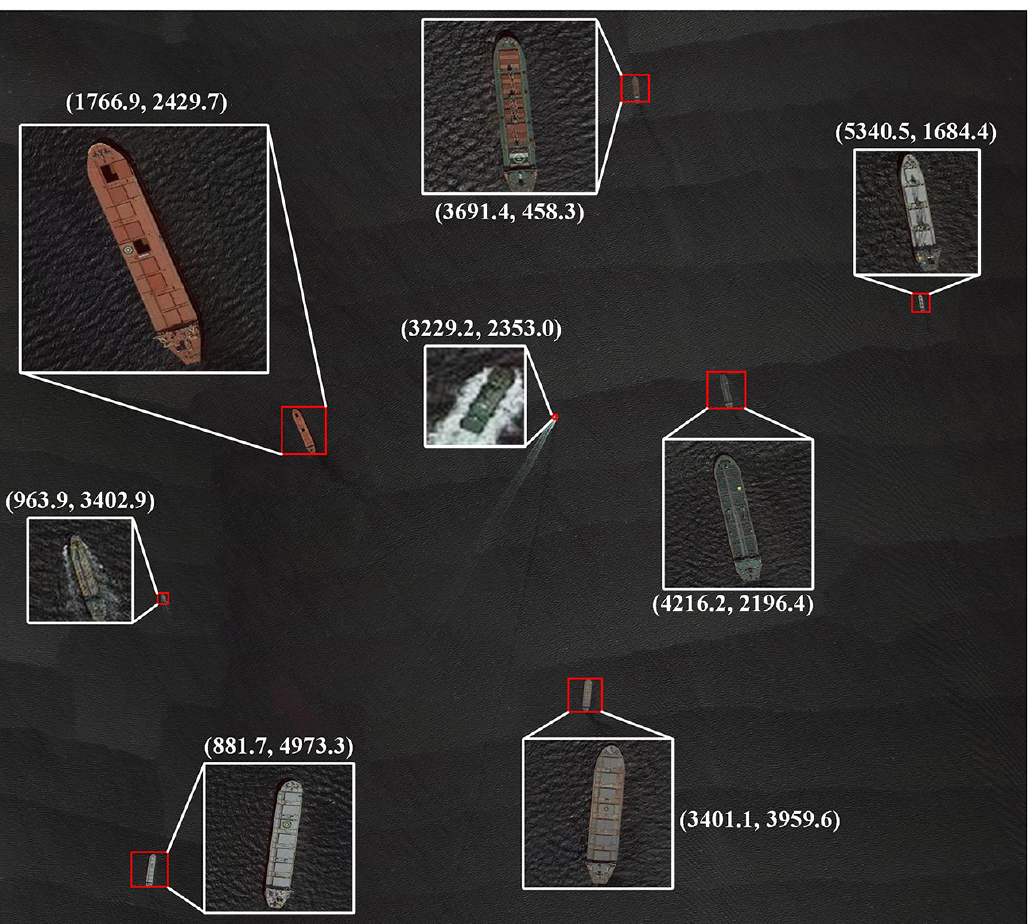
Figure 8. The result of the proposed scheme for one image in our dataset. The red boxes are the detection results of our ship detection method and the white boxes are the target patches extracted by our network. The two numbers are the image coordinates of the central point for each